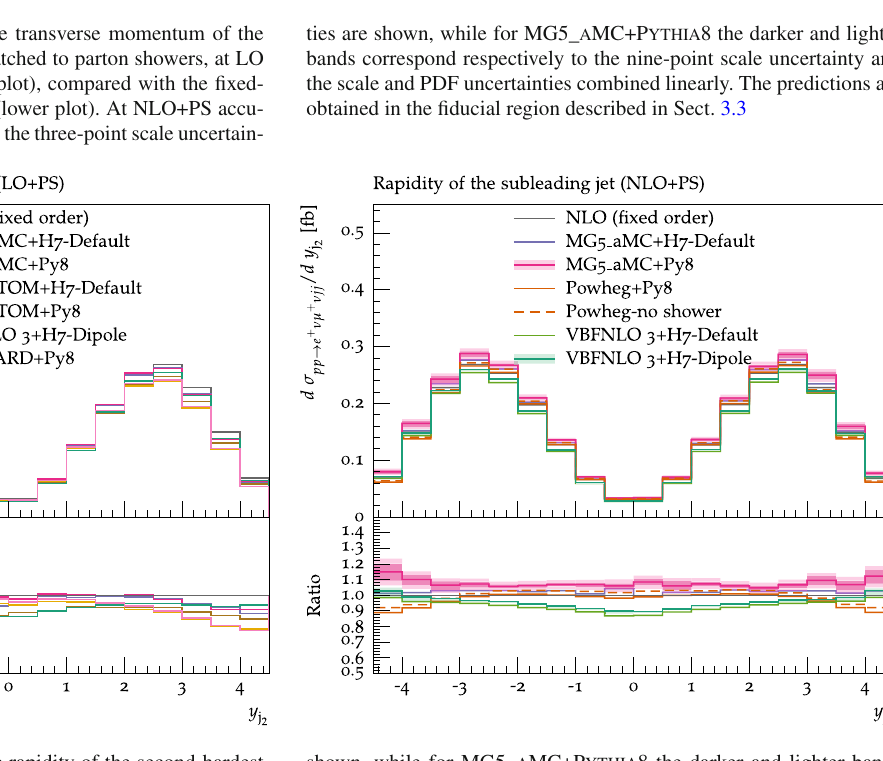
shown, while for MG5_aMC + Pythia8 the darker and lighter bands correspond respectively to the nine-point scale uncertainty and the scale and PDF uncertainties combined linearly. The predictions are obtained in the fiducial region described in Sect.